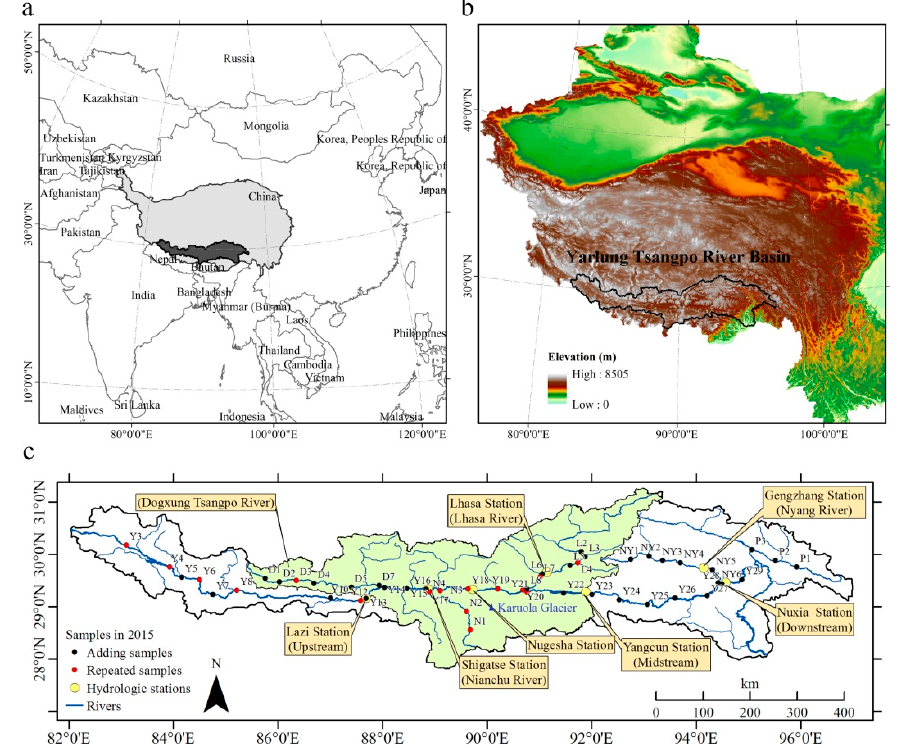
Figure 1. Map of the Yarlung Tsangpo River Basin showing the ( a ) location, ( b ) elevation, and ( c ) sampling locations in 2015 (elevation data were obtained from the Shuttle Radar Topography Mission (SRTM) 90 m digital elevation data downloaded from the Consultative Group for International Agricultural Research (CGIAR)-Consortium for Spatial Information (http: // srtm.csi.cgiar.org /